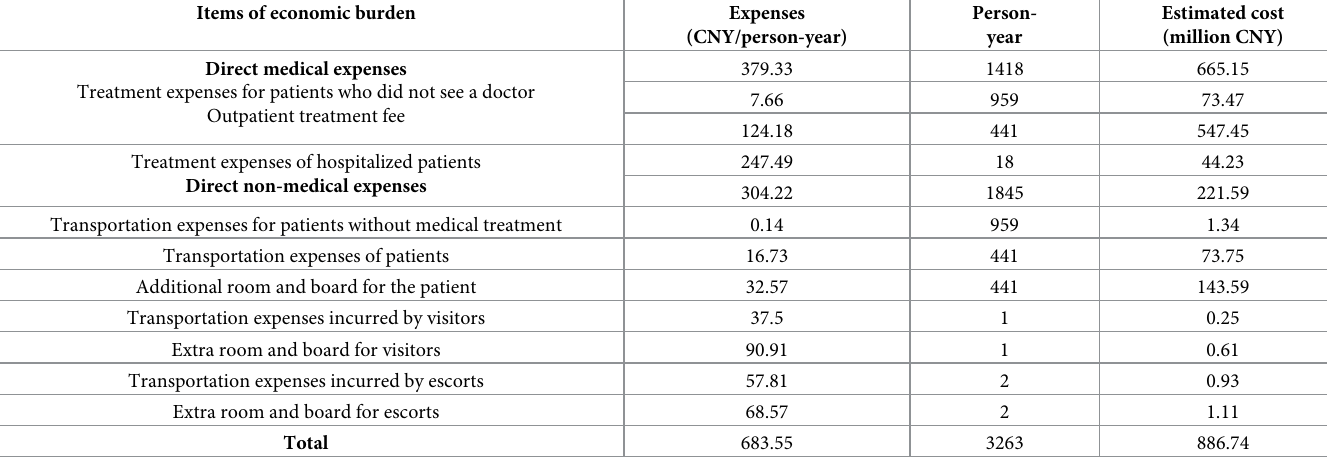
Table 5. The direct economic burden of AGI in the 4 weeks prior to interview in Zhejiang Province, July 2018-June